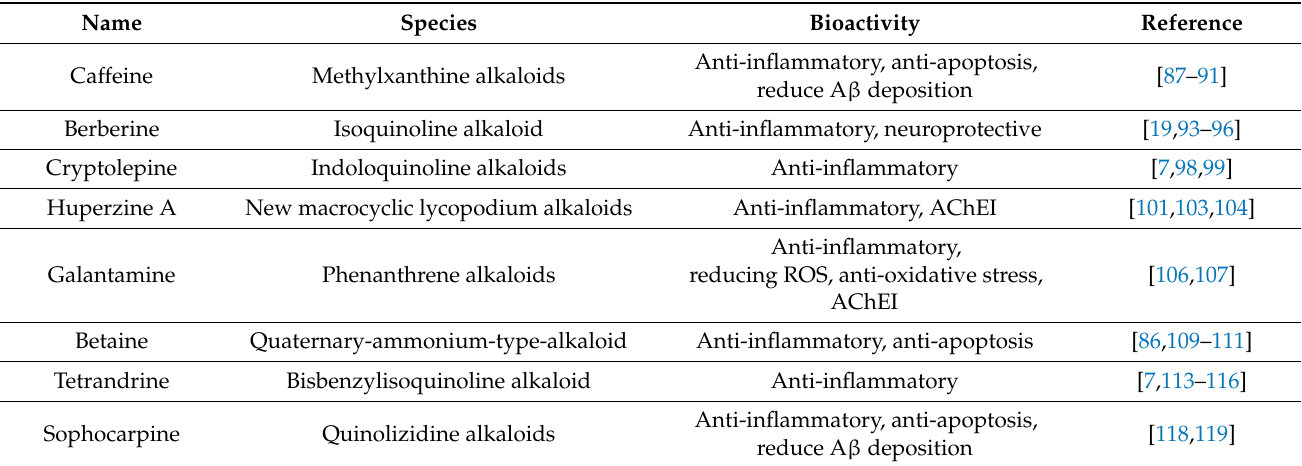
Table 1. Types and main activities of alkaloids natural